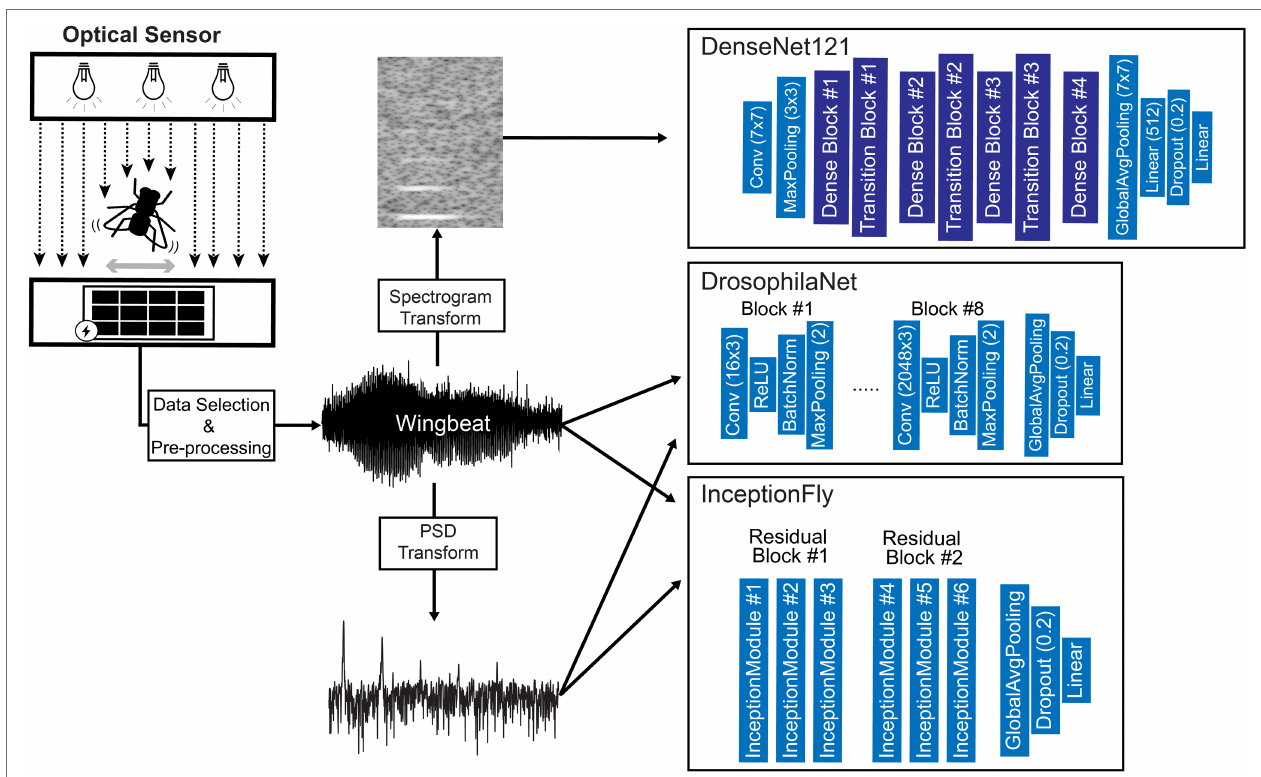
FIGURE 7 | Diagram of the data processing and modeling procedures including an illustration of the optical wingbeat sensor and the model architectures used in this study. For more information on the “Dense Block” and “Transition Block” layers, see Huang et al.